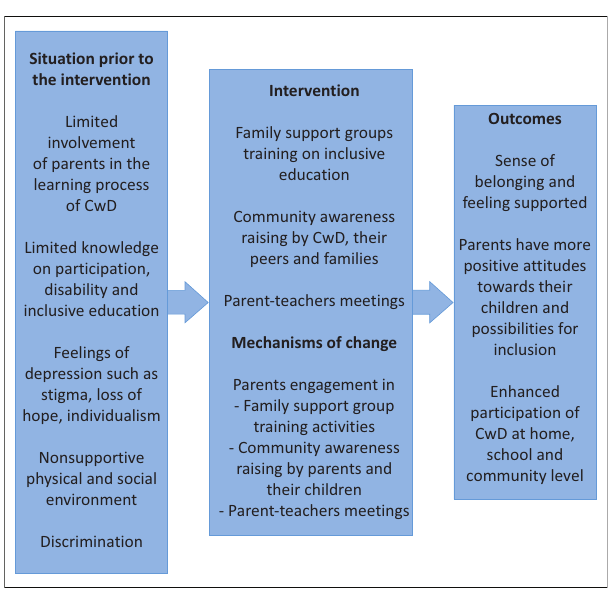
FIGURE 2: Diagrammatic representation of the parents’ intervention